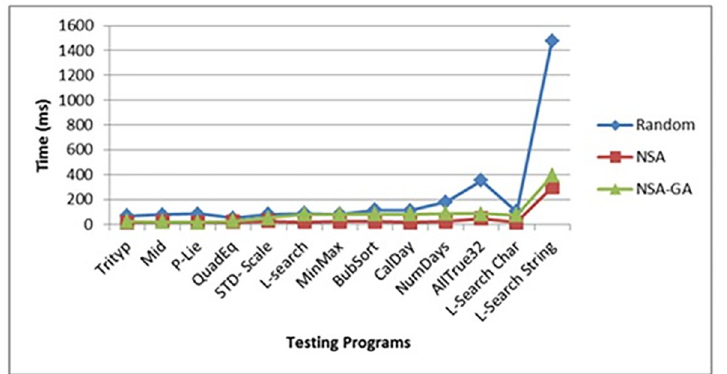
Fig 11. Testing time for random testing, NSA and NSA-GA methods for all benchmark programs.